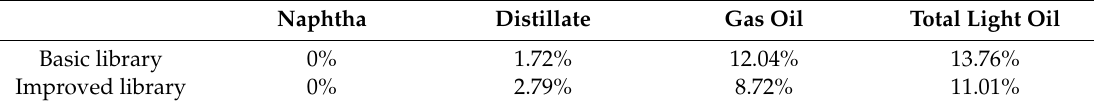
Figure 6. Comparisons of the boiling points for the residue feed in HCR with different values: ( a ) experimental value and simulated value with basic library; ( b ) experimental value, simulated values with basic and improved library (LV%: the liquid volume fraction). Table 1. Simulated residue feed composition contents with basic and improved feed library in